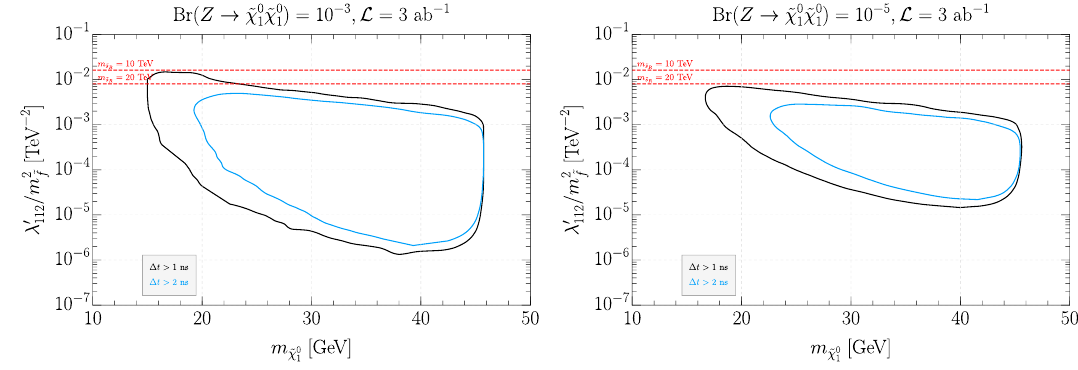
Figure 7 . 95% C.L. exclusion limits in the λ 0 10 − 5 . The horizontal dashed lines correspond to the present limits with m ˜ s eq.